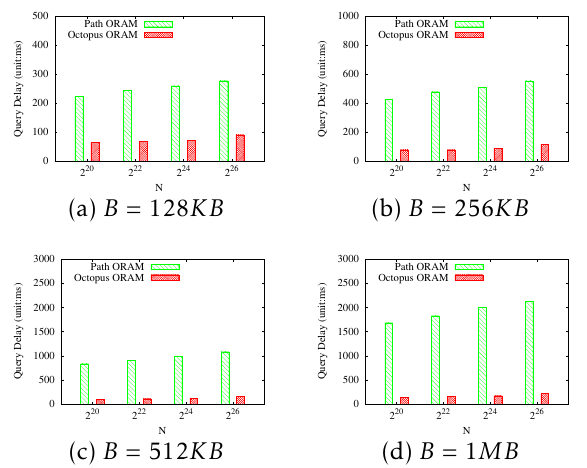
Storage Cost and Overhead. Table 3 compares Path ORAM and Octopus ORAM in terms of client-side storage cost and server-side storage overhead. As we can